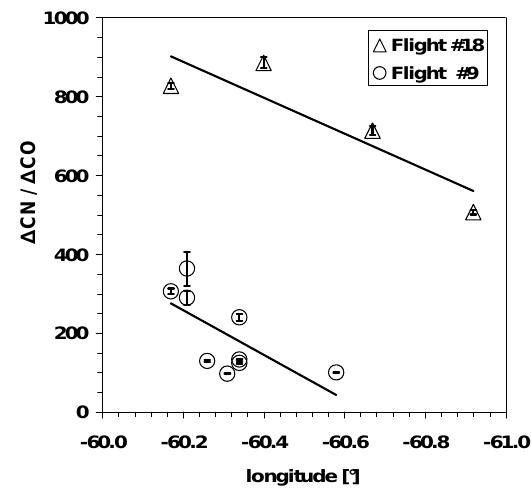
Fig. 12. 1 CN/ 1 CO ratios as a function of longitude from Manaus City ( − 3.08 ◦ , − 60.01 ◦ ) during Flight #9 and #18. One longitudinal degree corresponds to ∼ 111km.